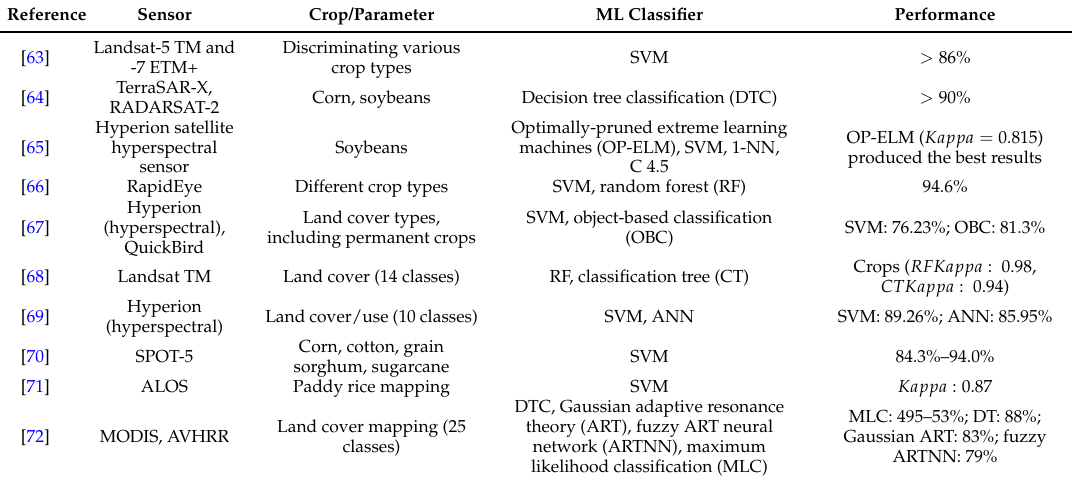
Classification of crop types using machine learning methods for indirect parameter